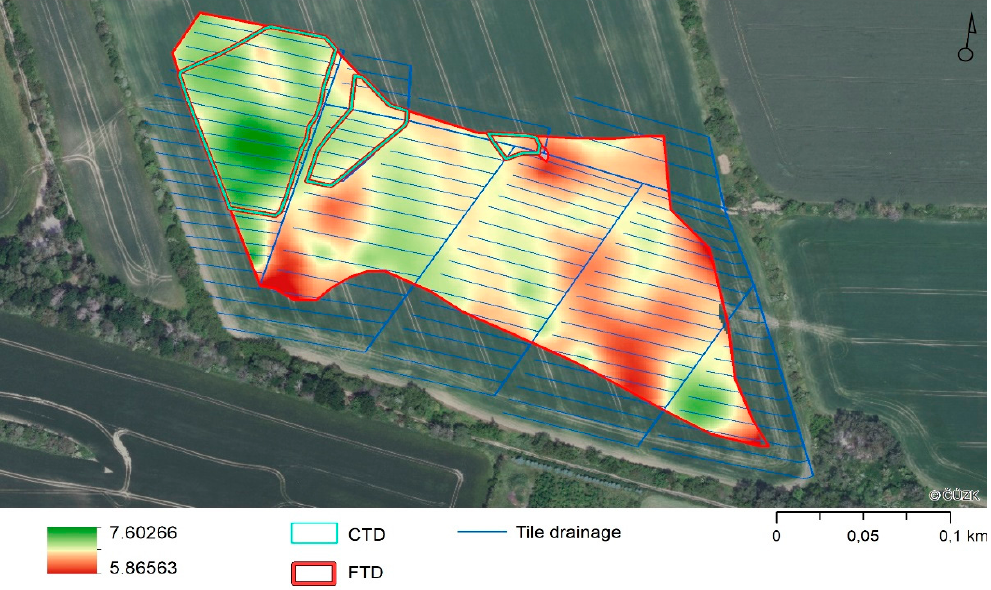
Figure 10. Grain yield map of spring barley (t/ha) at CTD and FTD sites with Dystric Cambisol taken at harvest on 15 August 2021.